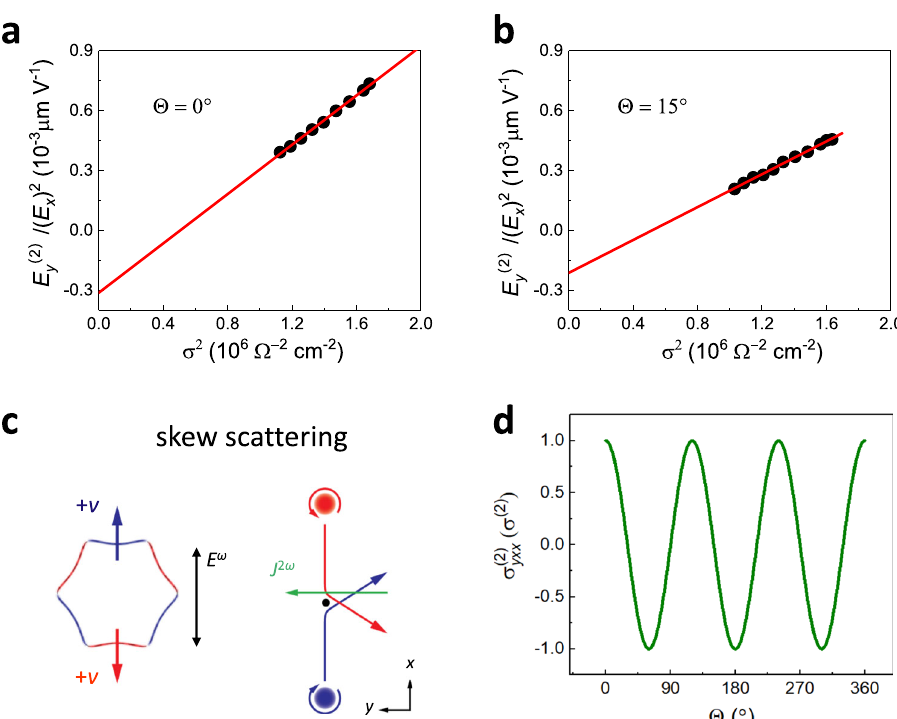
= E 2 versus the square of the longitudinal conductivity ( σ 2 ) for the current injection angles at Θ = 0° Fig. 4 Physical origin of nonlinear transport. a , b E 2 ð Þ y x ( a ), 15° ( b ) in temperature of 50 – 200 K, where the electron transport is strongly determined by electron-acoustic phonon scattering 28 . The red line is a linear fi t to the experimental data. c Schematic plot of the skew scattering of surface Dirac fermion and the induced nonlinear transverse transport. d The theoretical nonlinear transverse conductivity versus the applied electric fi eld direction Θ based on the skew scattering of